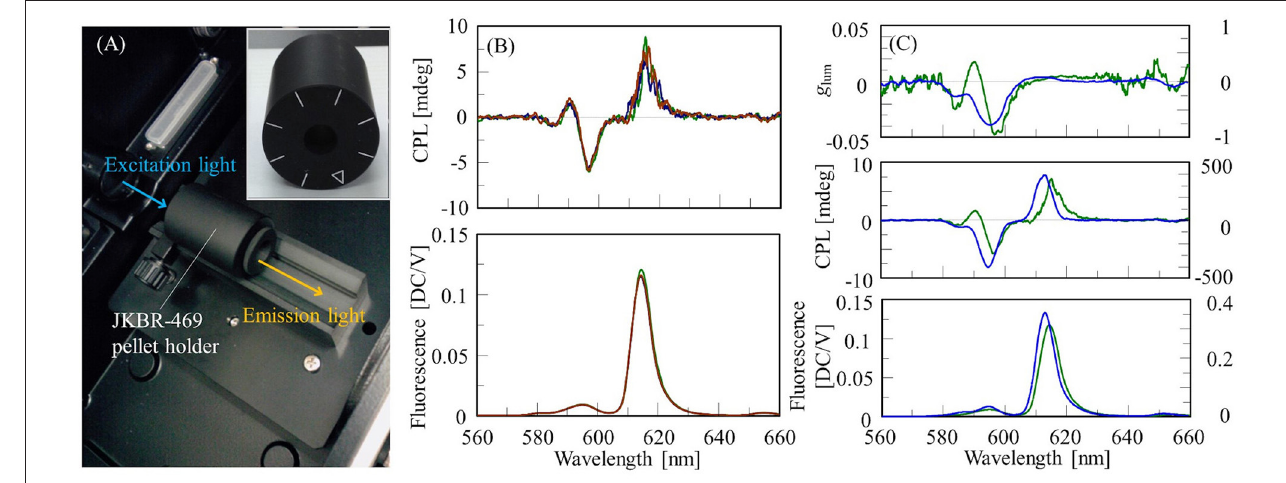
FIGURE 1 | (A) Sample compartment of CPL-300 with installed JKBR-469 pellet holder, and front view of JKBR-469. (B) CPL and fluorescence spectra of Eu(facam) 3 /KBr pellet at rotation angles of 0 ◦ (green), 45 ◦ (blue), and 90 ◦ (red). (C) g lum , CPL and fluorescence spectra of Eu(facam) 3 /KBr pellet (green, left vertical axis) and in DMSO solution (blue, right vertical l axis).